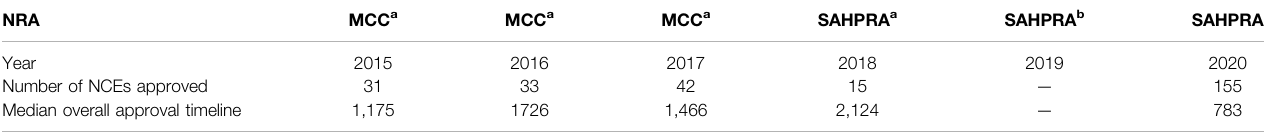
TABLE 3 | Median overall approval timelines for NCEs from 2015 – 2020.